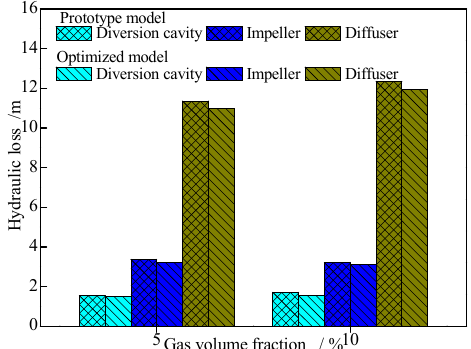
Figure 13. Hydraulic loss diagram with different gas volume fractions.